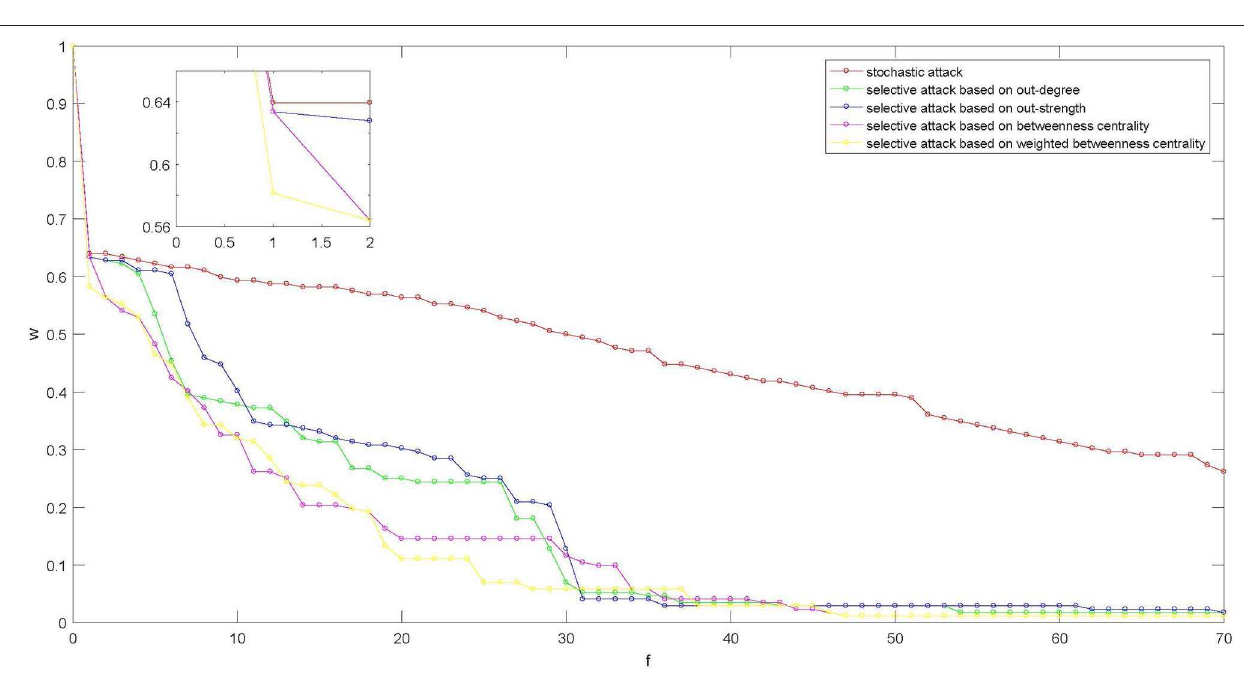
FIGURE 7 | The maximum SCC size of the GRN. Notes: f is the number of removal nodes. The selective removal removes nodes in decreasing order of their